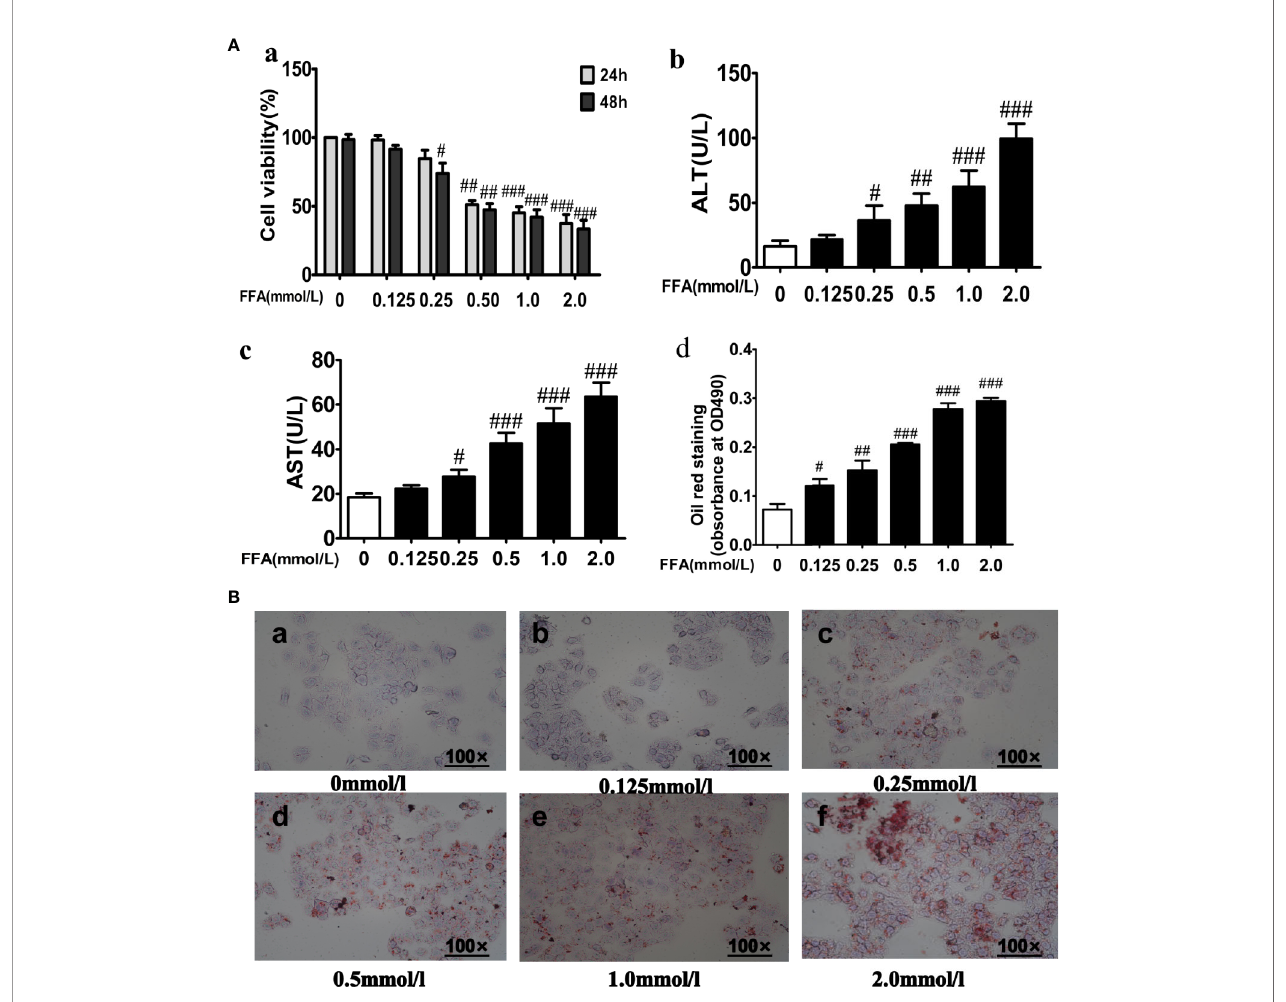
FIGURE 4 | Effects of free fatty acids (FFA) on cell viability and lipid accumulation in LO2 cells. (A) LO2 cells were exposure to the different concentrations of FFA for 24 or 48 h, cell viability (a), ALT (b), AST (c) and quantitative results of graph-B detected by spectrophotometer at OD490nm (d). (B) The effect of FFA on the lipid accumulation of LO2 cells. n =3 ( n , the number of experiment), ( # P < 0.05, ## P < 0.01, and ### P < 0.001 vs . control